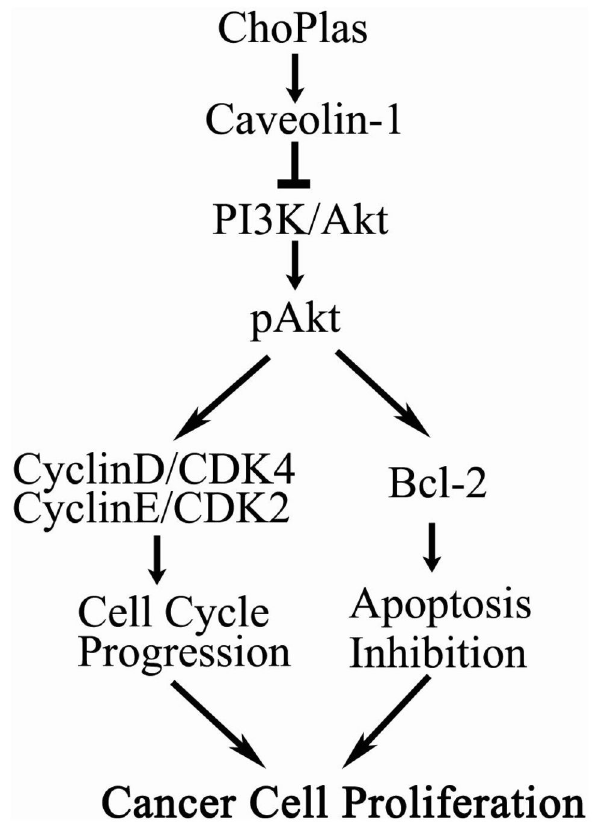
Figure 8. Hypothesized model for the proliferation inhibition mechanism of ChoPlas on hepatoma cells. Exogenous natural ChoPlas activates caveolin-1, affecting PI3K/Akt pathway signals and decreasing cell cycle regulatory proteins and Bcl-2